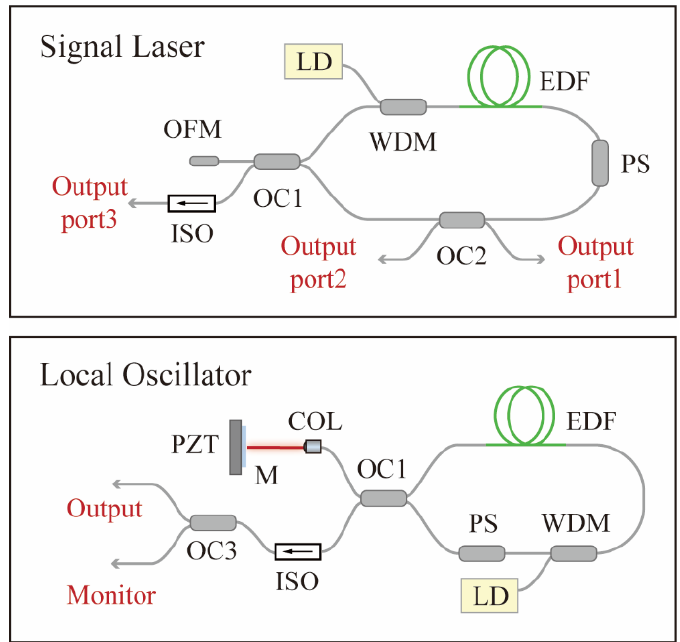
Figure 1. Schematic of the mode-locked lasers based on nonlinear amplifier loop mirror. COL, collimator; EDF, Er-doped gain fiber; ISO, isolator; LD, pump laser diode; M, reflective mirror; OC, optical fiber coupler; OFM, optical fiber mirror; PS, phase shifter; PZT, piezoelectric transducer; WDM, wavelength division multiplexer.